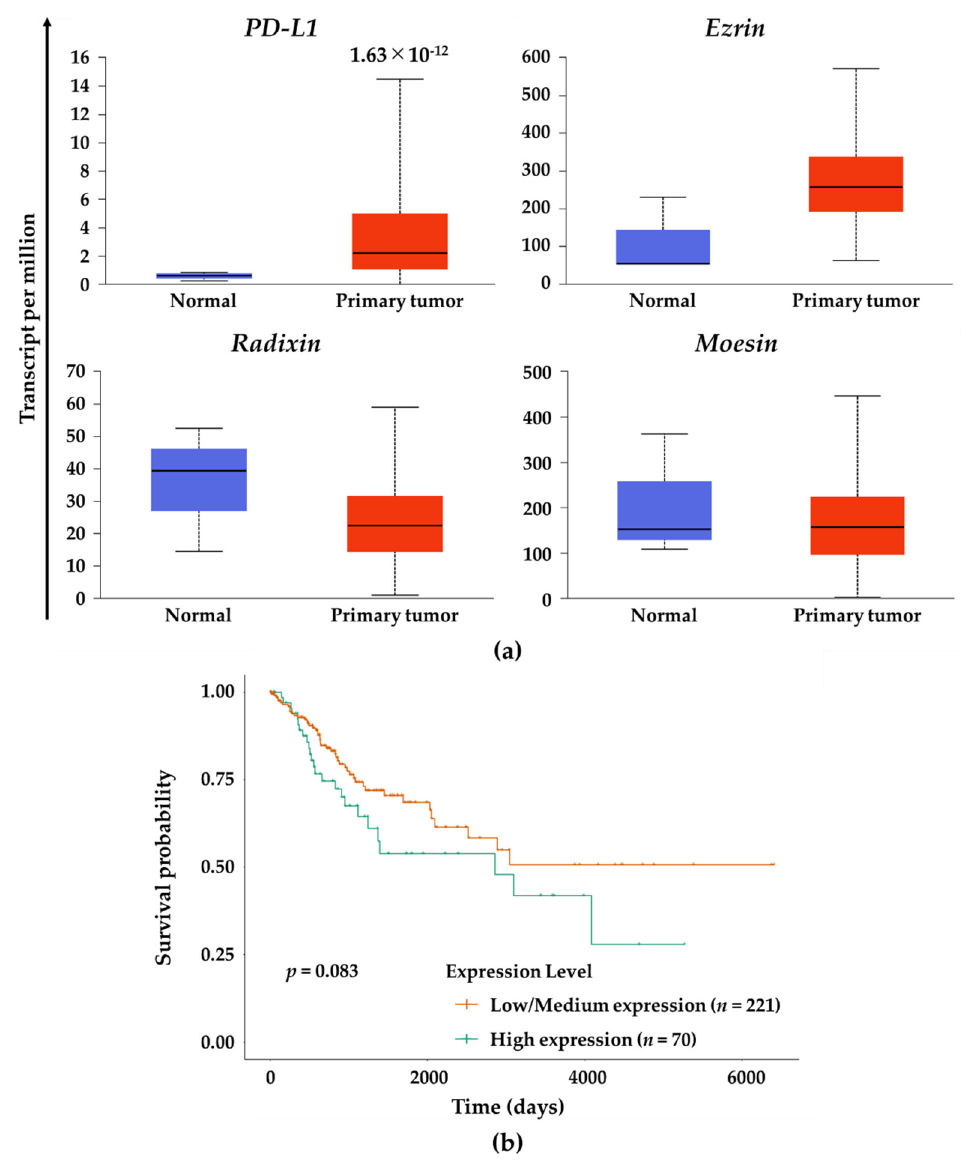
Figure 7. Gene expression analysis of PD-L1 and the ERM family in human cervical SCC tissue and effects of moesin expression on the survival probability of patients with cervical SCC. ( a ) Gene expression levels of PD-L1, ezrin, radixin, and moesin in the human cervical SCC tissues ( n = 305) and normal tissues ( n = 3) using RNA-sequencing (seq) data obtained from The Cancer Genome Atlas (TCGA) database. The estimated gene expression values based on RNA-seq data are presented as transcripts per million. All data were expressed as boxplots. ( b ) Survival probability curves for the patients with cervical SCC who had moesin expression at high ( n = 70) or at low/medium ( n = 221) levels.